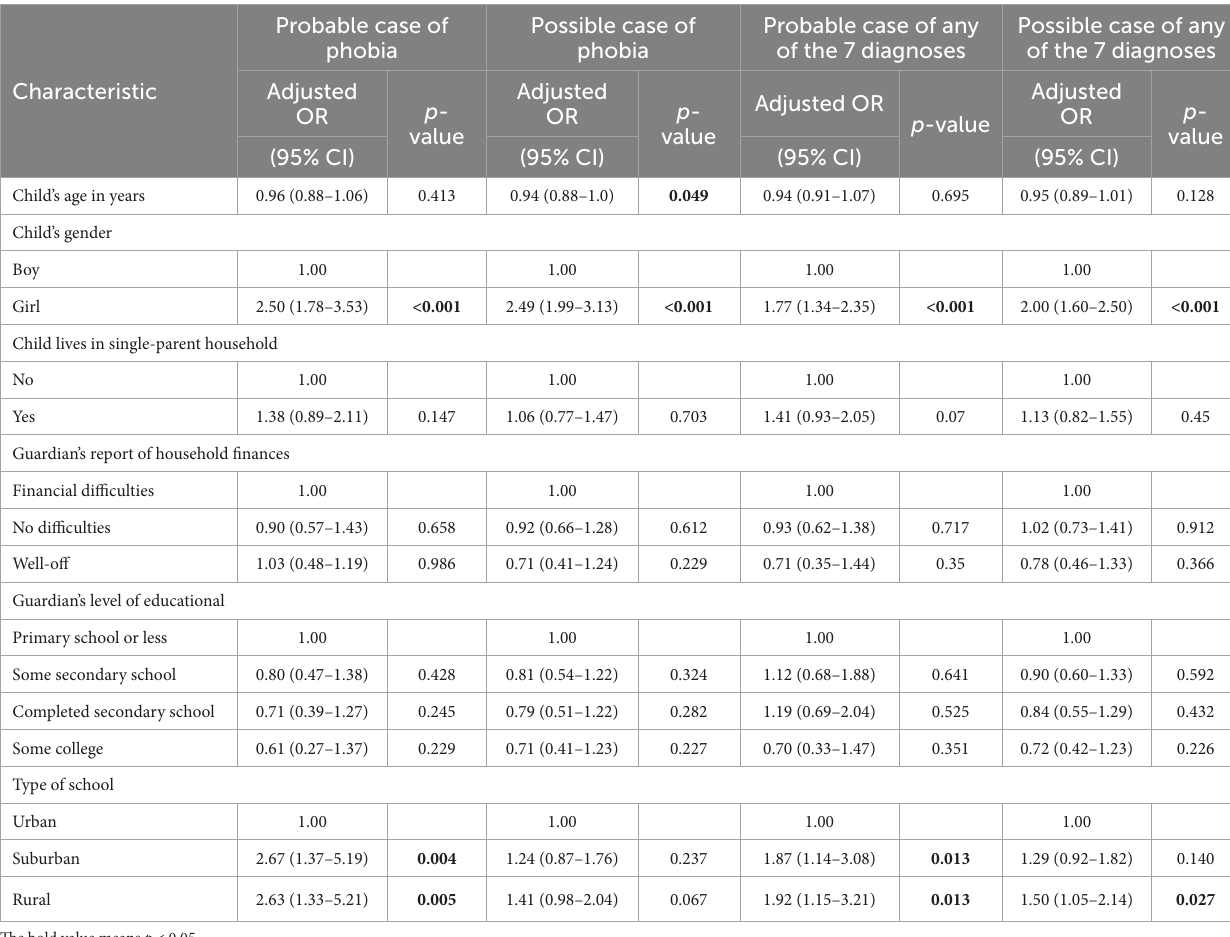
TABLE 5 Logistic regression analysis of factors associated with the prevalence of possible and probable cases of phobia among 1,479 primary school children in Tianjin, China based on diagnostic result of the self-report Dominic Interactive video game.